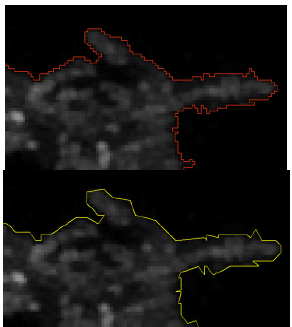
Figure 8. Elemination of zigzag effects (top:before,